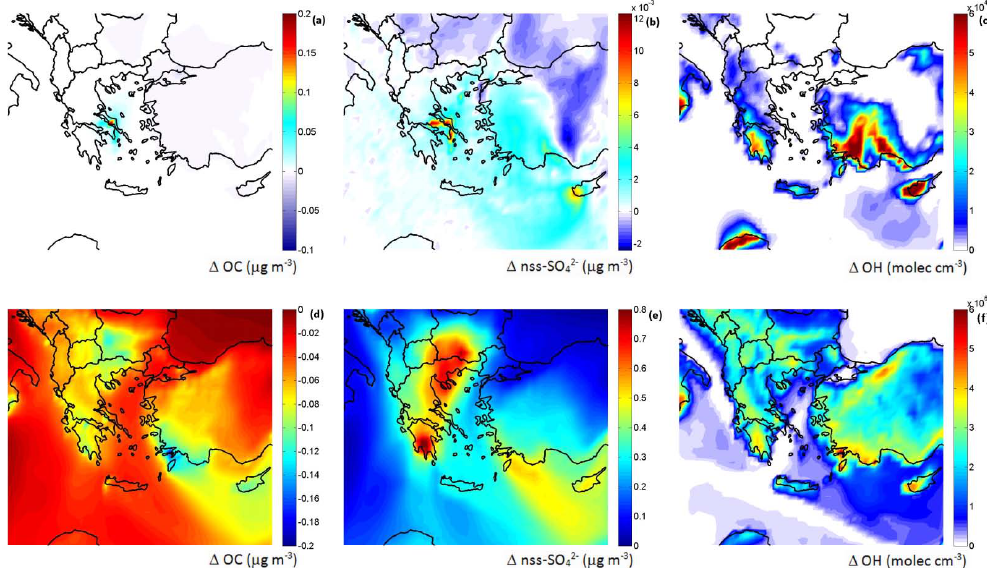
Fig. 5. Impact of biogenic emissions on surface levels of OC, nss-SO 2 − minus the “Base” simulations, averaged over each one-month simulation period: (left) 1 OC, (middle) 1 nss-SO 2 − row shows winter (December 2008), bottom row shows summer (July 2008) results. Units are µgm − 3 for 1 OC and 1 nss-SO 2 − are different. For 1 OH units are 10 4 moleccm − 3 for (c) and 10 6 moleccm − 3 for (f)